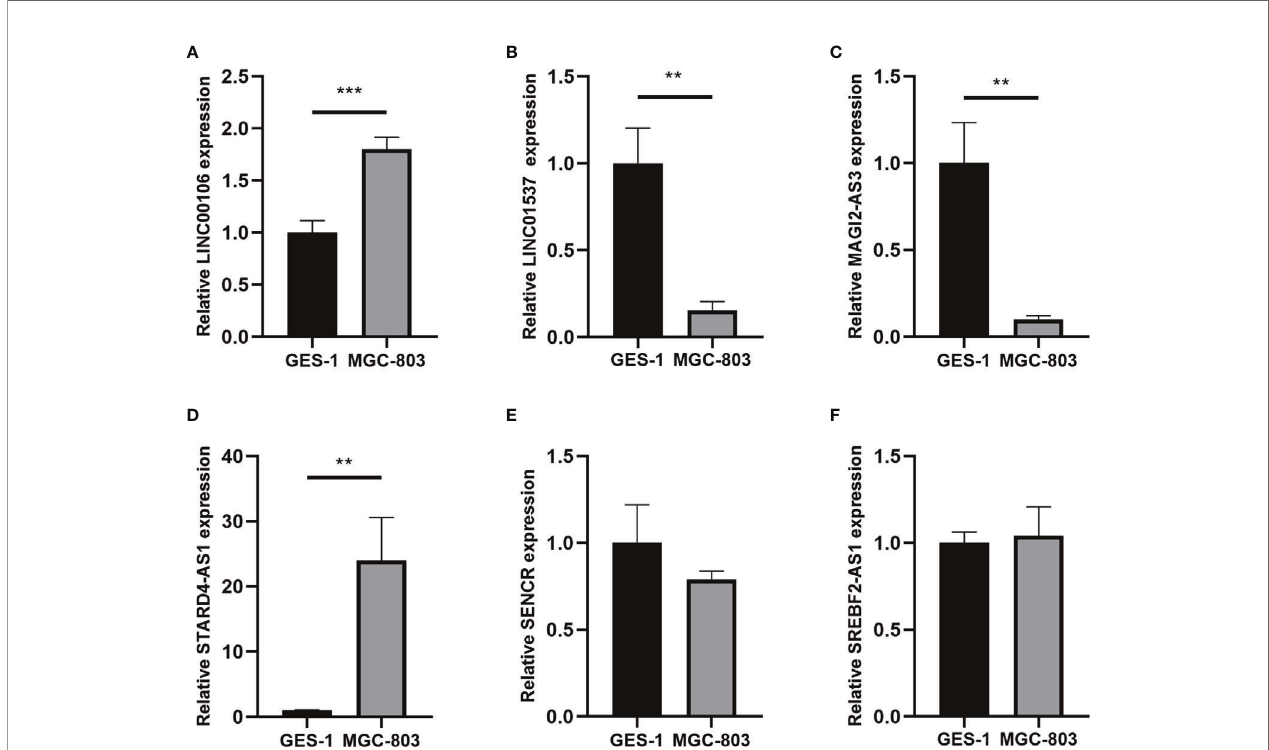
FIGURE 13 | (A – F) Expression of six lncRNAs from the prognostic signature in GC cell line MGC-803 and normal human gastric epithelial cell line GES-1. ** p < 0.01, and *** p <